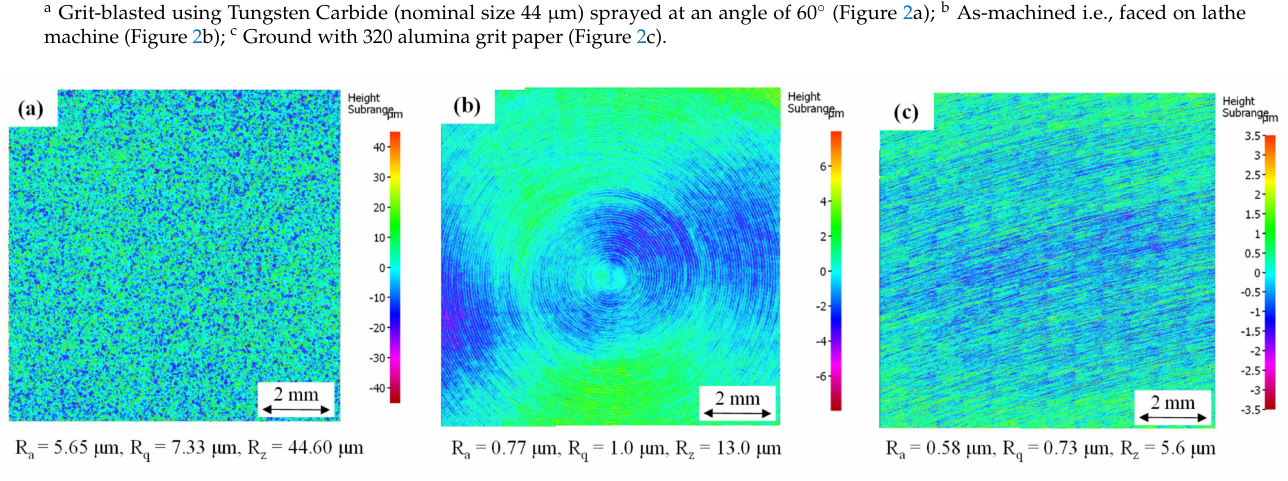
Figure 2. 3D surface profile measured by focus variation technique for different surface preparation conditions: ( a ) grit-blasted, ( b ) as-machined, and ( c ) ground (adopted from